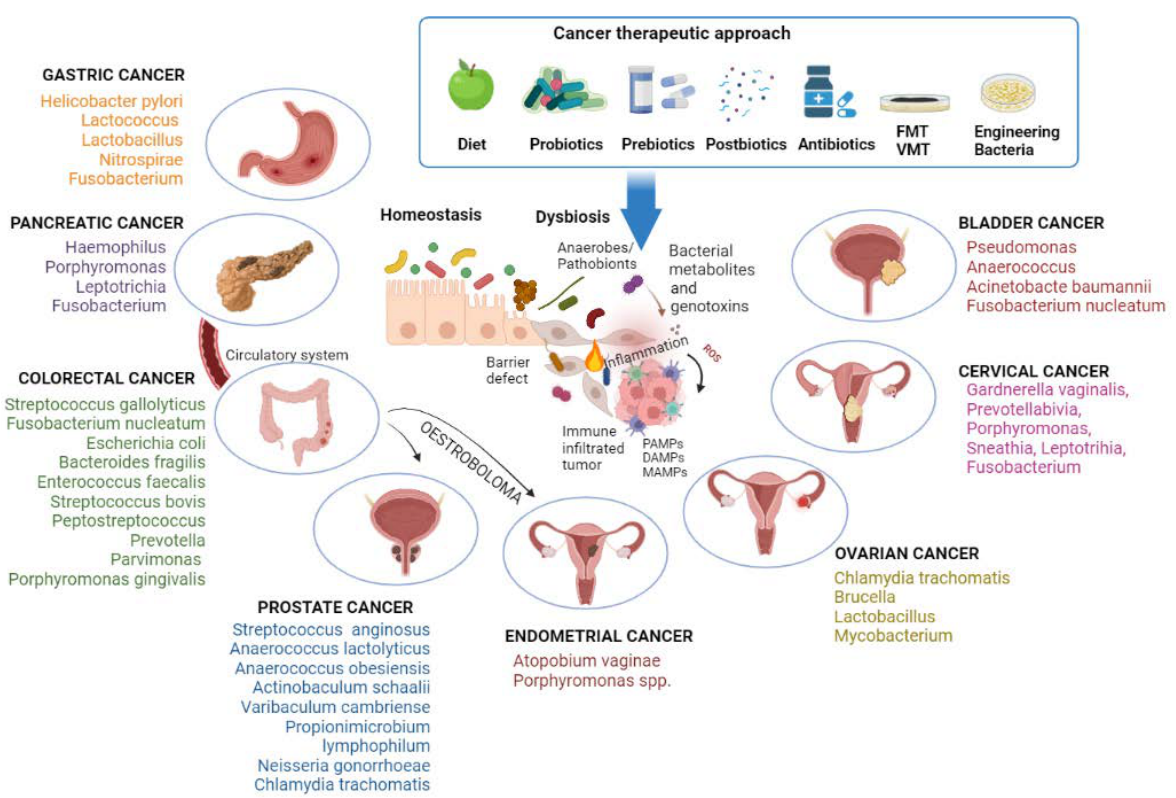
Figure 1. The condition of dysbiosis, mainly the increase in anaerobes/pathobionts, promotes carcinogenesis. Bacterial genotoxins damage cellular DNA, stimulate local inflammation, and activate the innate immune system through the molecular patterns associated with microorganisms (MAMPs), the pathogen-associated molecular patterns (PAMPs), or the damage-associated molecular patterns (DAMPs). Gut pathogenic bacteria can directly drive the process of pancreatic carcinogenesis by migrating through the bloodstream or indirectly influence endometrial and prostate carcinogenesis through oestrobolome. Different anticancer therapies act by counteracting dysbiosis. Image created with BioRender (https://biorender.com; accessed on 1 July 2022). FMT: transplantation of fecal microbiota; VMT: transplantation of vaginal microbiota.